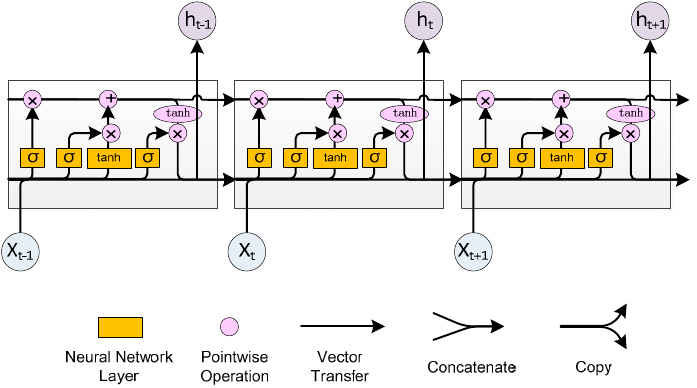
Figure 2. LSTM architecture with one memory block.